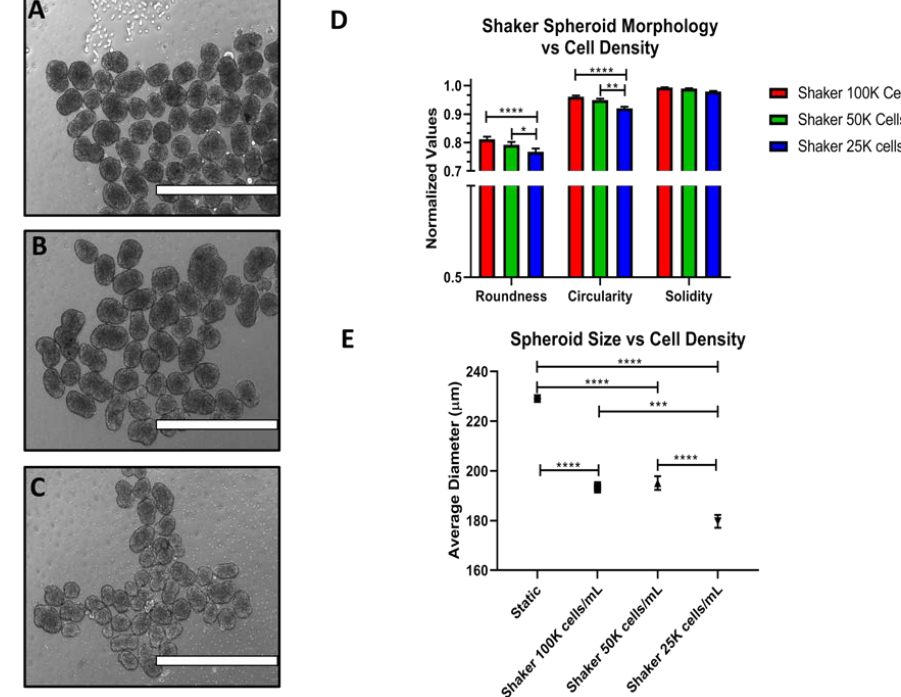
Figure 8. The effects of cell density on OVCA420 spheroid properties under shaking conditions. Spheroid characteristics were monitored at 100,000 cells/mL ( A ), 50,000 cells/mL ( B ) and 25,000 cells/mL ( C ) for 72 h. ( D ) Quantification of RCS values. ( E ) Quantification of spheroid size. Scale Bar: 1000 µm. ( n = 3).